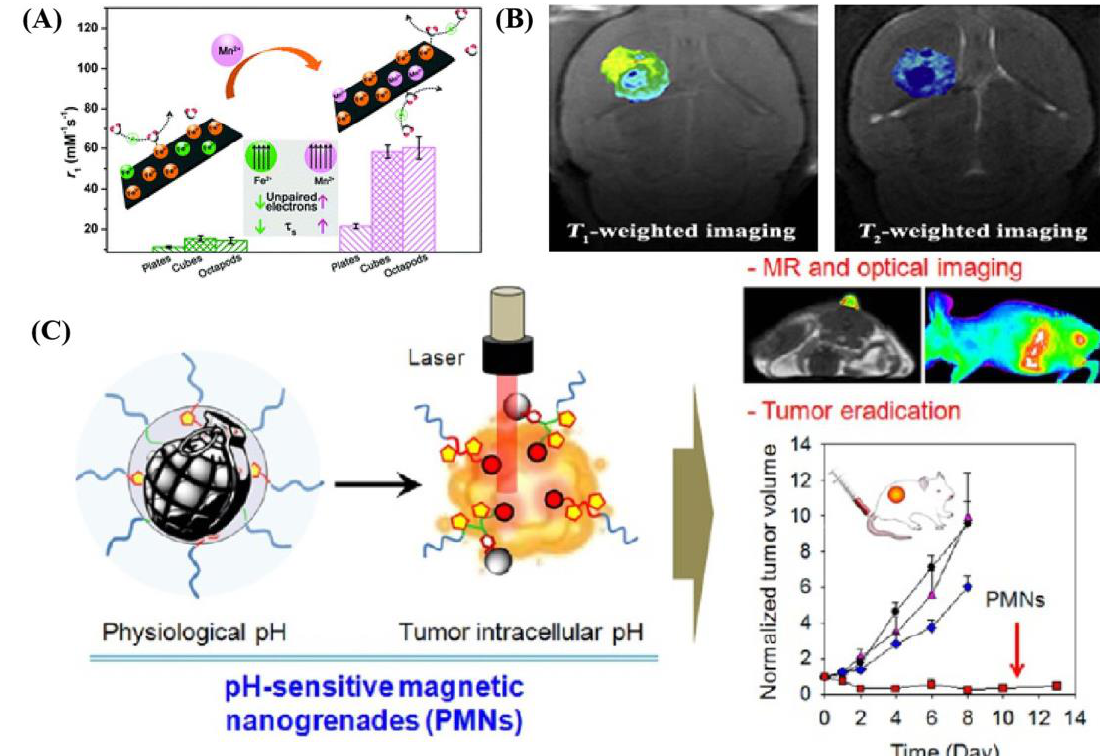
Figure 2. Metal-based magnetic composites as a functional candidate in ( A ) surface manganese substitution in magnetite crystals enhancing T 1 contrast ability by increasing electron spin relaxation; ( B ) T 1 –T 2 dual-modal MRI of brain gliomas using PEGylated Gd-doped Fe 3 O 4 ; ( C ) Schematic illustration of pH-sensitive self-assembled structure for MRI and treatment of resistant heterogeneous tumors. These are reprinted with permission from Zhao et al. (2018, RSC), Xiao et al. (2014, Elsevier), and Ling et al. (2014, ACS), respectively.